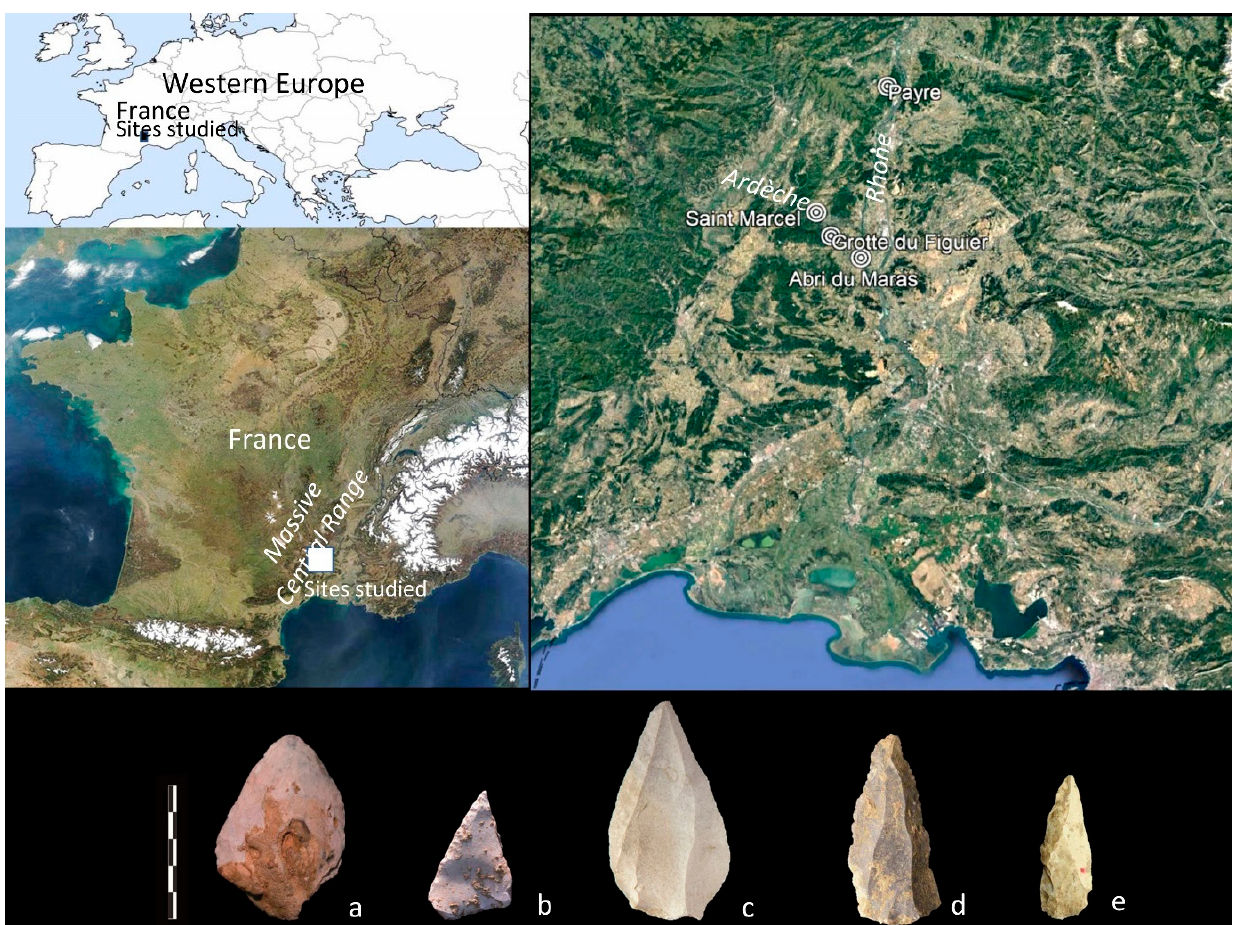
Figure 1. Location of the sites from which assemblages were analysed for this study, and points from the oldest Payre unit Ga, MIS 7 ( a , b ) and youngest Abri du Maras units 4.1 and 4.2, MIS 3 ( c – e ) assemblages in our study. Maps by M Lombard and artefact photographs by M-H. Moncel.